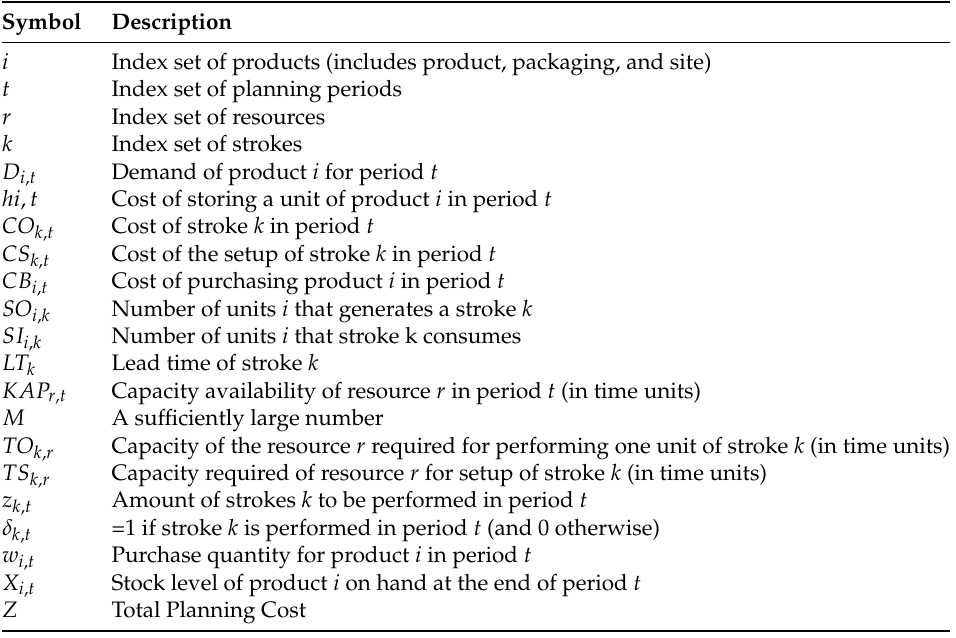
Table 3. Parameters and decision variables for the GMOP model